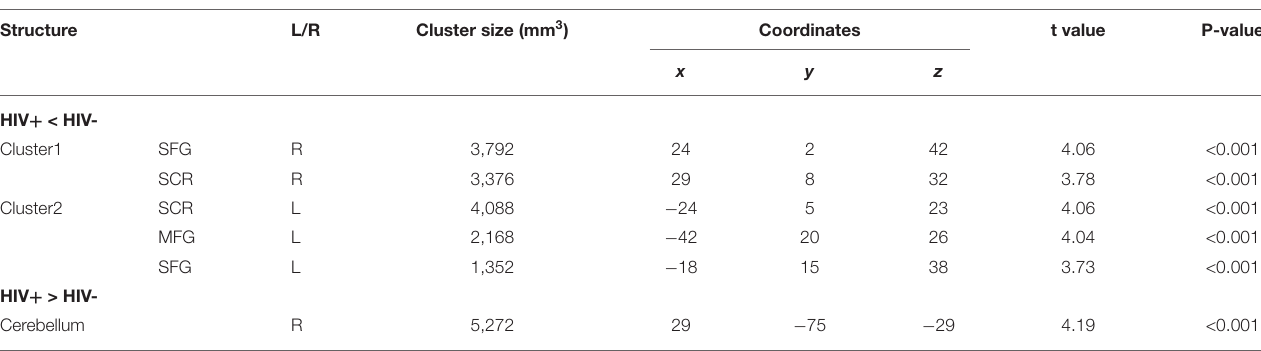
TABLE 2 | Deformation differences between HIV + and HIV-